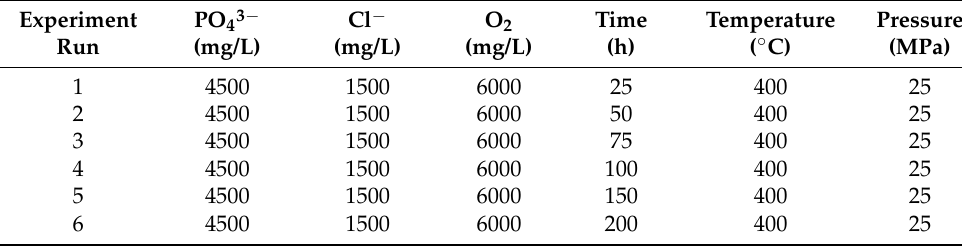
Figure 1. Schematic diagram of supercritical water experimental apparatus. Table 2. Experimental conditions used for corrosion tests.